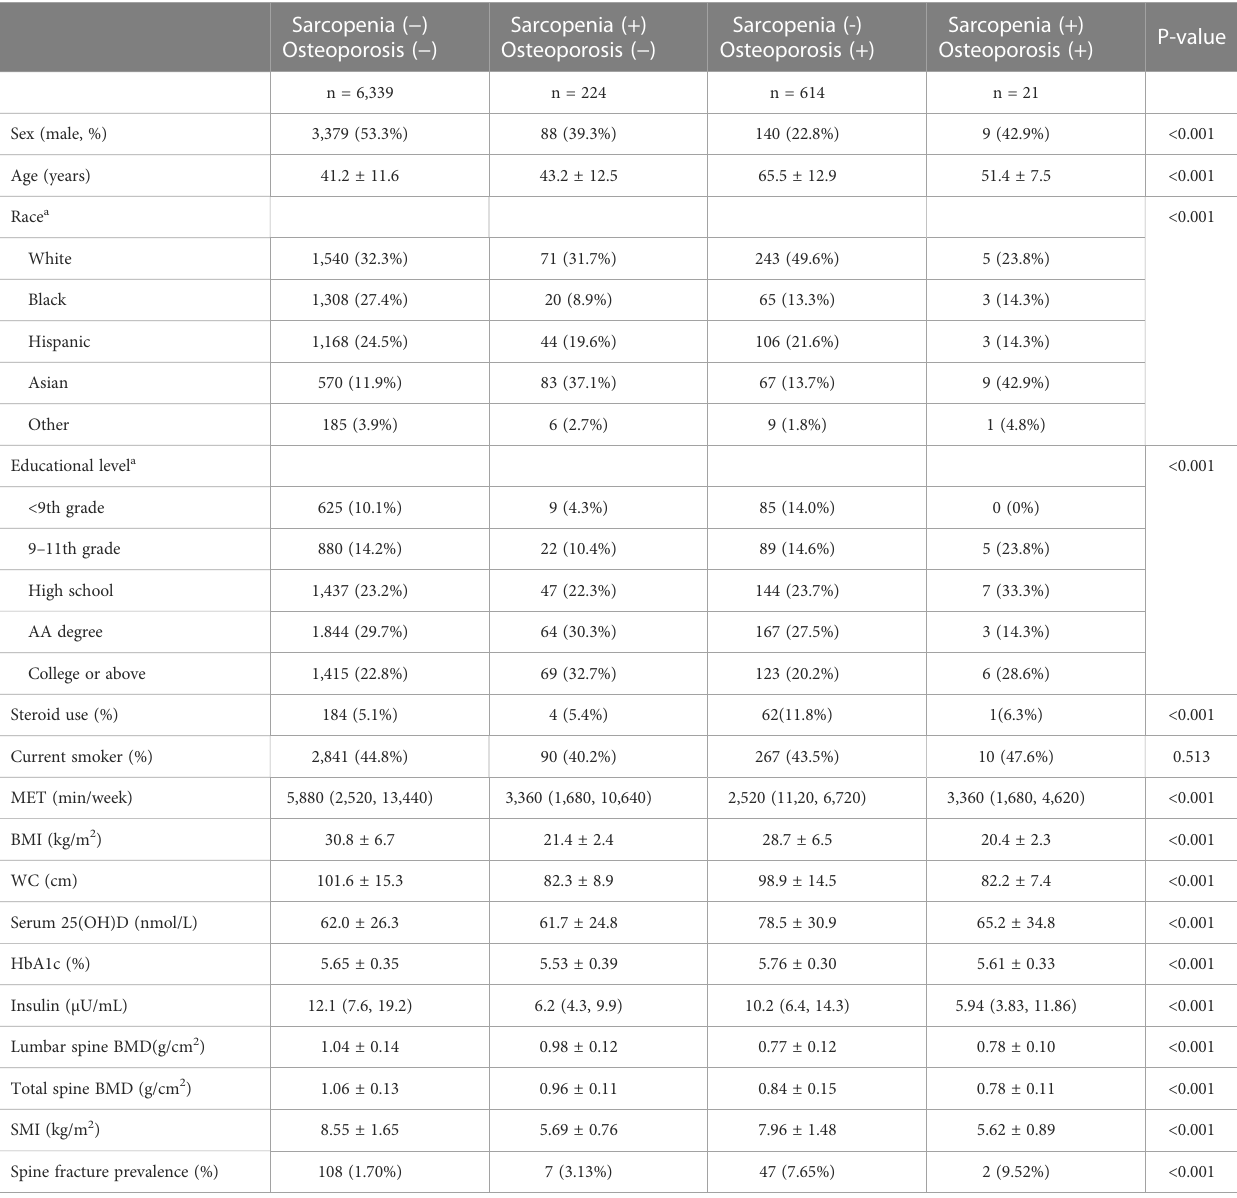
TABLE 3 Characteristics of prediabetes adults with sarcopenia, with osteoporosis, and with osteosarcopenia.